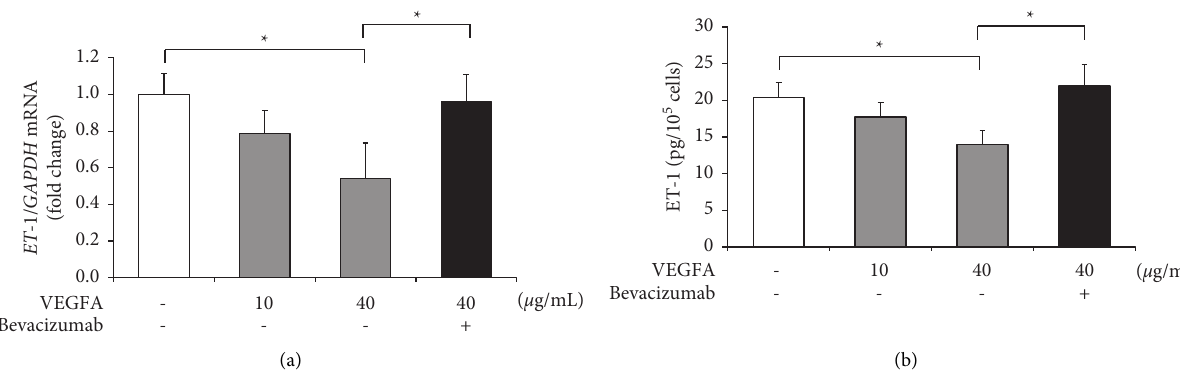
Figure 4: Vascular endothelial growth factor A (VEGFA) is associated with the suppression of ET-1 production in cultured human glomerular microvascular endothelial cells (hGECs). hGECs were plated in 24-well plates (1 × 10 5 cells/well) for ELISA or 60mm culture dishes (1 × 10 6 cells/dish) for RT-PCR. hGECs that were 90% confluent were serum-starved for 24h before the experiments were performed. hGECs were treated with 0, 10, and 40ng/mL of VEGFA or with a combination of 40ng/mL VEGFA and 1 µ M bevacizumab for 8h. The levels of ET-1 mRNA (a) and ET-1 protein (b) were measured using real-time RT-PCR and the ELISA after VEGFA and bevacizumab treatment. Data shown are means ± SD ( n � 3; ∗ p < 0.05). The experiments were repeated at least three times, with reproducible results.